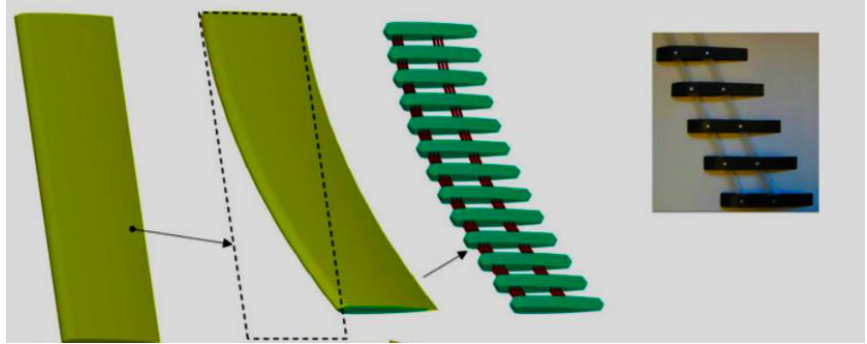
Figure 17. Design for a flexing parallelogram wing [66]